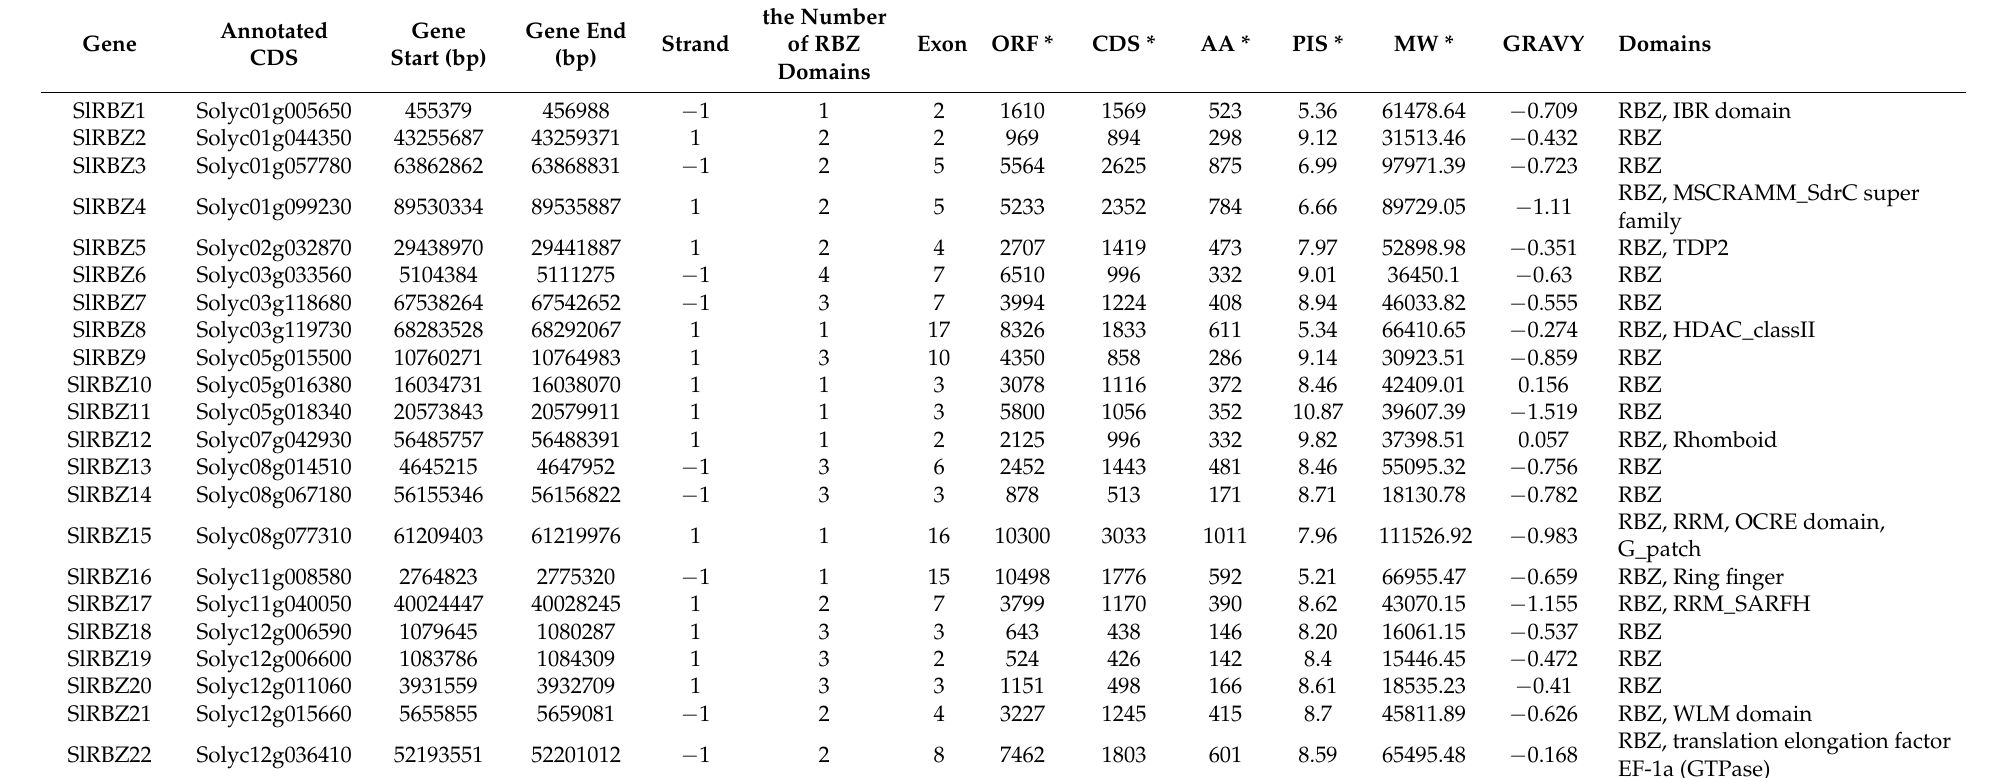
Table 1. Description of SlRBZ genes in